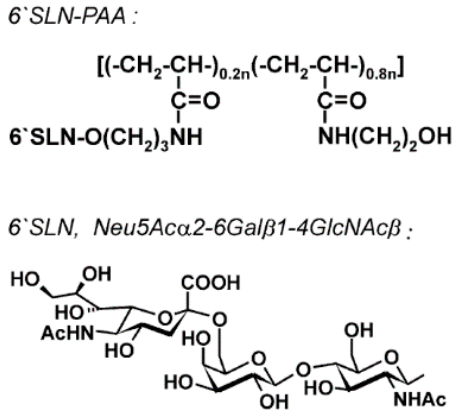
Figure 1. The chemical structure of 6 ′ SLN-PAA and 6 ′ SLN. Reprinted from Gambaryan AS, Boravleva EY, Matrosovich TY, Matrosovich MN, Klenk HD, Moiseeva E V., et al. Polymer-bound 6 ′ sialyl- N -acetyllactosamine protects mice infected by Influenza virus. Antiviral Res 2005, with permission from Elsevier [70].